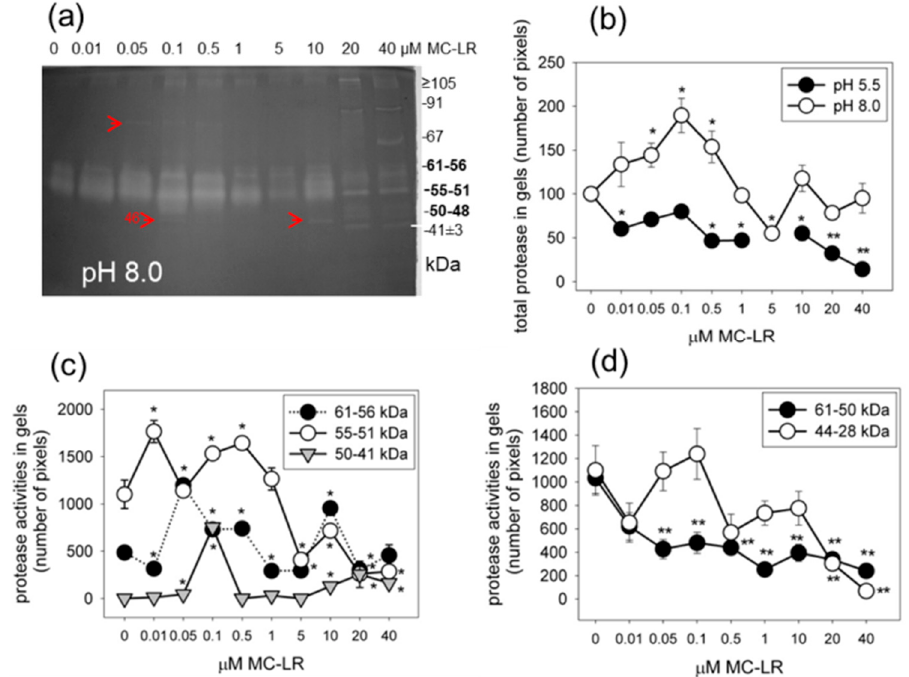
Figure 4. The dose-dependent effects of MC-LR on protease activities of whole S. alba seedlings after 4 days of exposure. ( a ) In-gel activity assay of alkalic proteases. Red arrowheads indicate isoenzymes with minor activities, but characteristic only for MC-LR treatments. ( b ) Quantification by the CP Atlas method based on activity gels of total acidic and alkaline protease activities, shown as percentages of controls (100%). ( c ) Quantification by the CP Atlas method based on activity gels of 61–56, 55–51 and 50–41 kDa protease activities under alkaline conditions. ( d ) Quantification by the CP Atlas method based on activity gels of 61–50 and 44–28 kDa acidic protease activities. ( b – d ) Shows that only the alkaline proteases show significant increases in the presence of MC-LR. Significance of differences between controls and treated ones were evaluated by t -tests, Sigma-Plot 12.0; * p < 0.05; ** p <